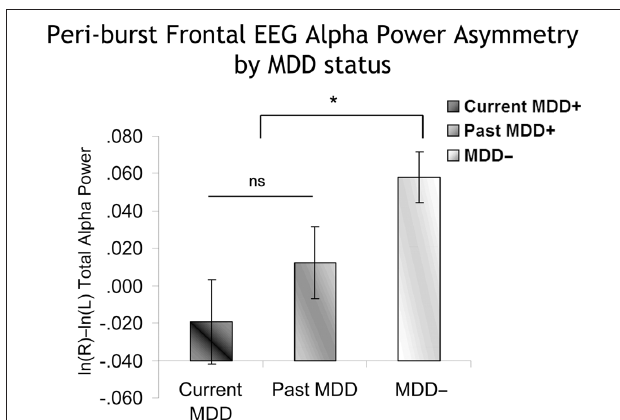
FIGuRE 8 | Peri-burst frontal alpha asymmetry scores as a function of MDD status. Error bars reflect standard error. Y -axis is ln μV 2 /cm 2 . As with conventional metrics ( Figure 7 ), both currently and previously depressed individuals had significantly lower peri-burst asymmetry scores than never-depressed